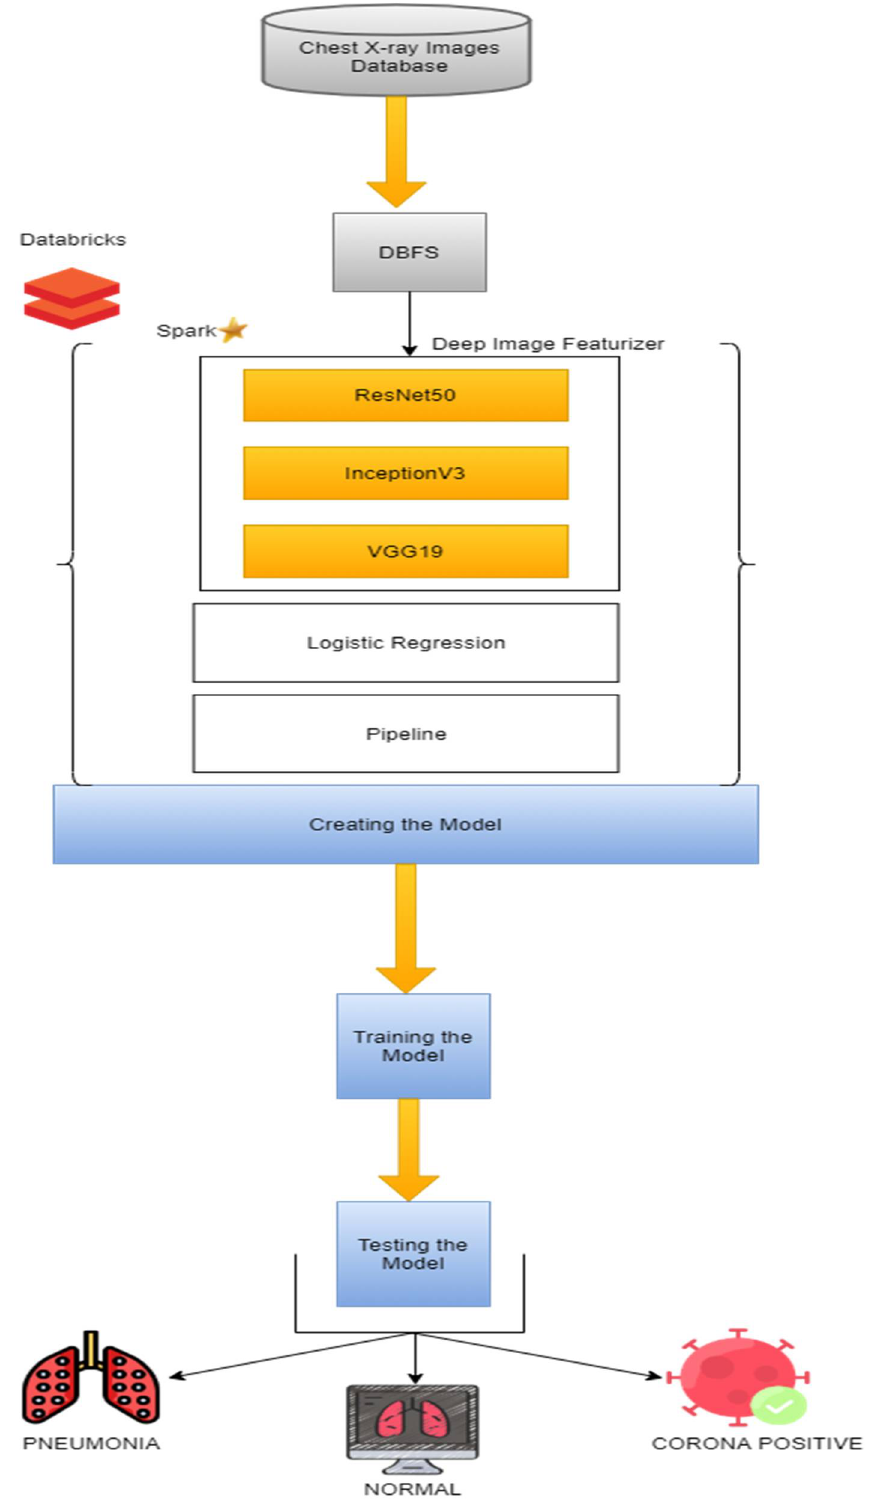
Figure 4. The working model incorporates deep-transfer learning with the Apache Spark architec- ture InceptionV3, Residual Net (ResNet50), and Visual Geometry group (VGG19) on Data Bricks File System(DBFS).